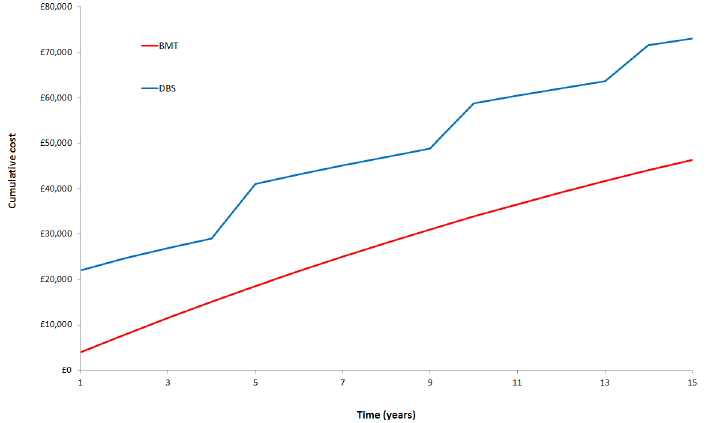
Fig 3. Cumulative discounted costs over 15 years.